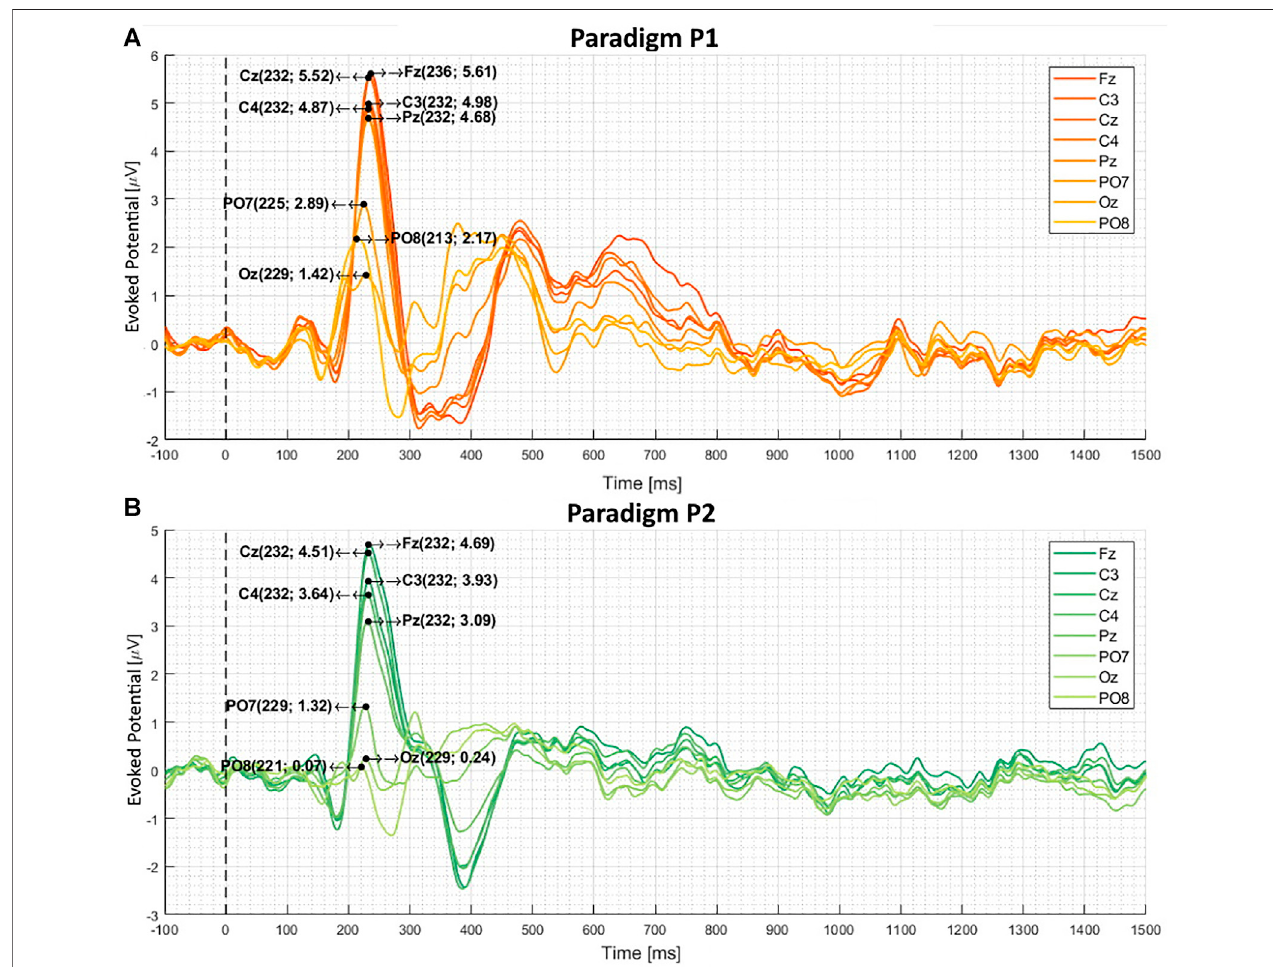
FIGURE4| Thecalculateddifferencebetweentargetandnon-targetstimuliaveragedover21subjects (A) and (B) depictsthevisualevokedpotentialproducedby paradigms P1 and P2, respectively. These two paradigms had female faces as targets and gray-scale images as non-targets. The black dotted line marks the stimulus presentation. The P300 latency and amplitude are noted in the brackets [(ms), ( μ V )].